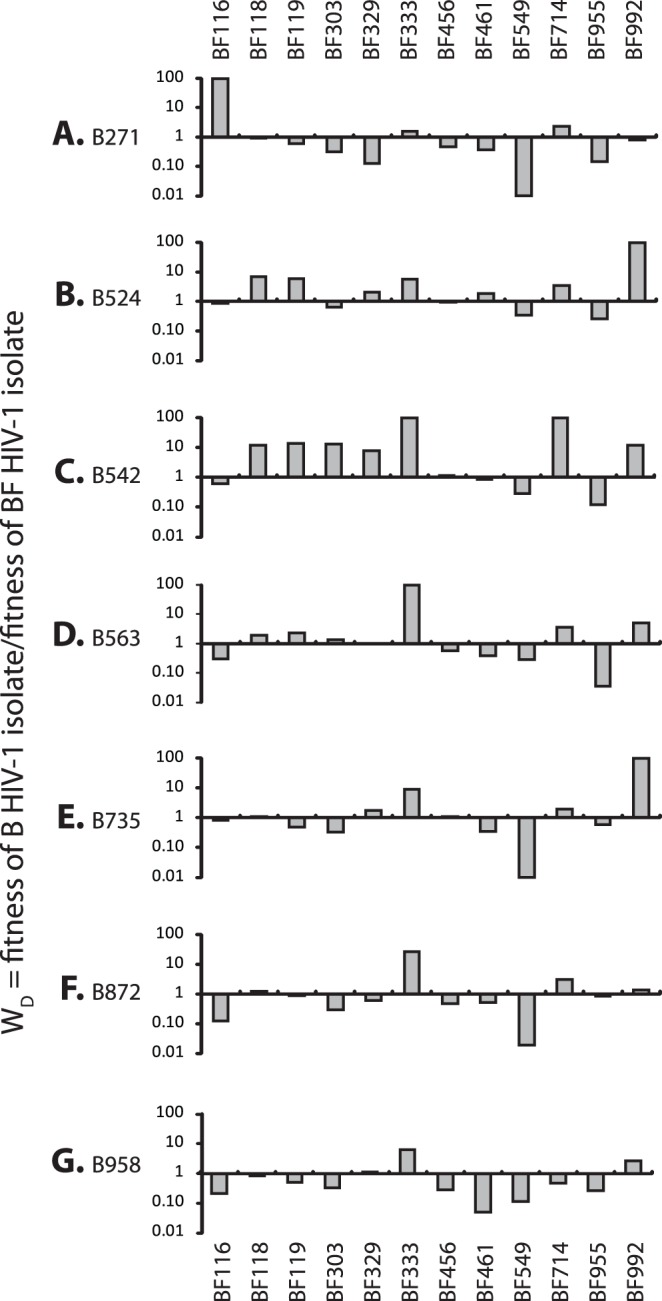
Comparing the relative replicative fitness difference (WD) of HIV-1 subtype B and BF recombinants from Argentina in direct competitions.Subtype B strains a) B271 b) B524, c) B542 d) B563 e) B735 f) B872 g) B958 were competed against CRF-BF-like isolates (BF116, BF118, BF119, BF303, BF329, BF333, BF456, BF461, BF549, BF714, BF955, BF992) in PHA-stimulated, IL2-treated PBMCs. The fitness difference represented on the Y axis ranges from 0.01 to 100. Bars represent the fitness of the isolates shown on the Y-axis.